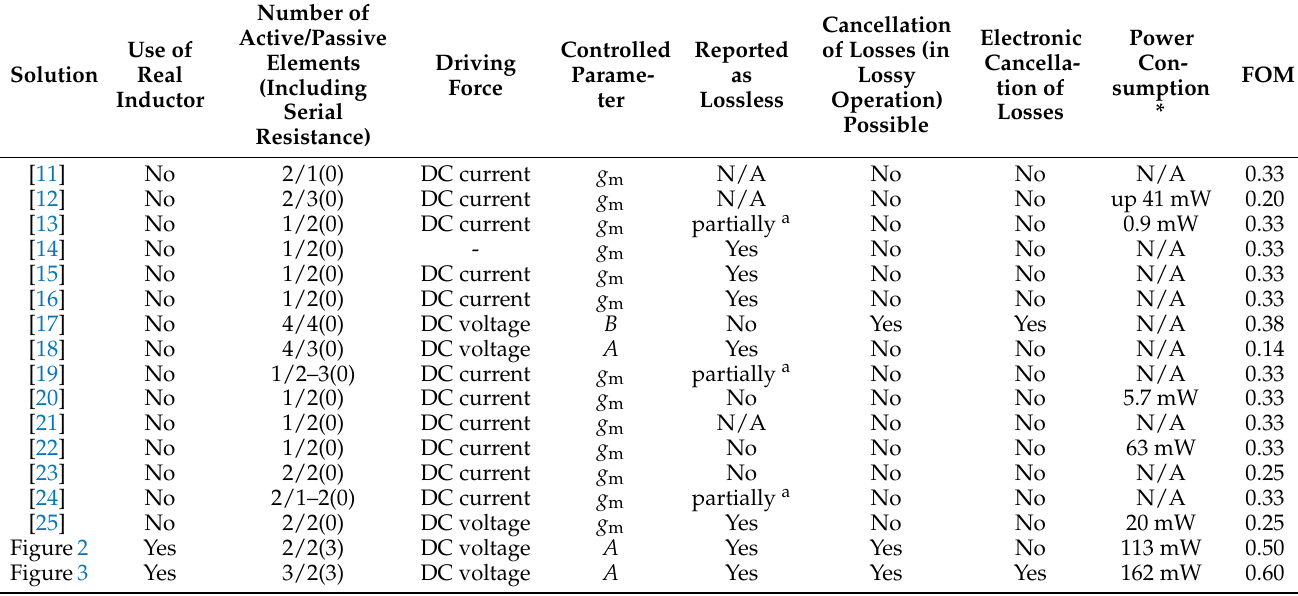
Figure 3. Topology of electronically adjustable inductance value and R S cancellation using two VGAs and CCII+. Table 1. Brief comparison of typical solutions of electronically adjustable inductance simulators (impedance inverters using capacitors) with presented methodology of real inductance